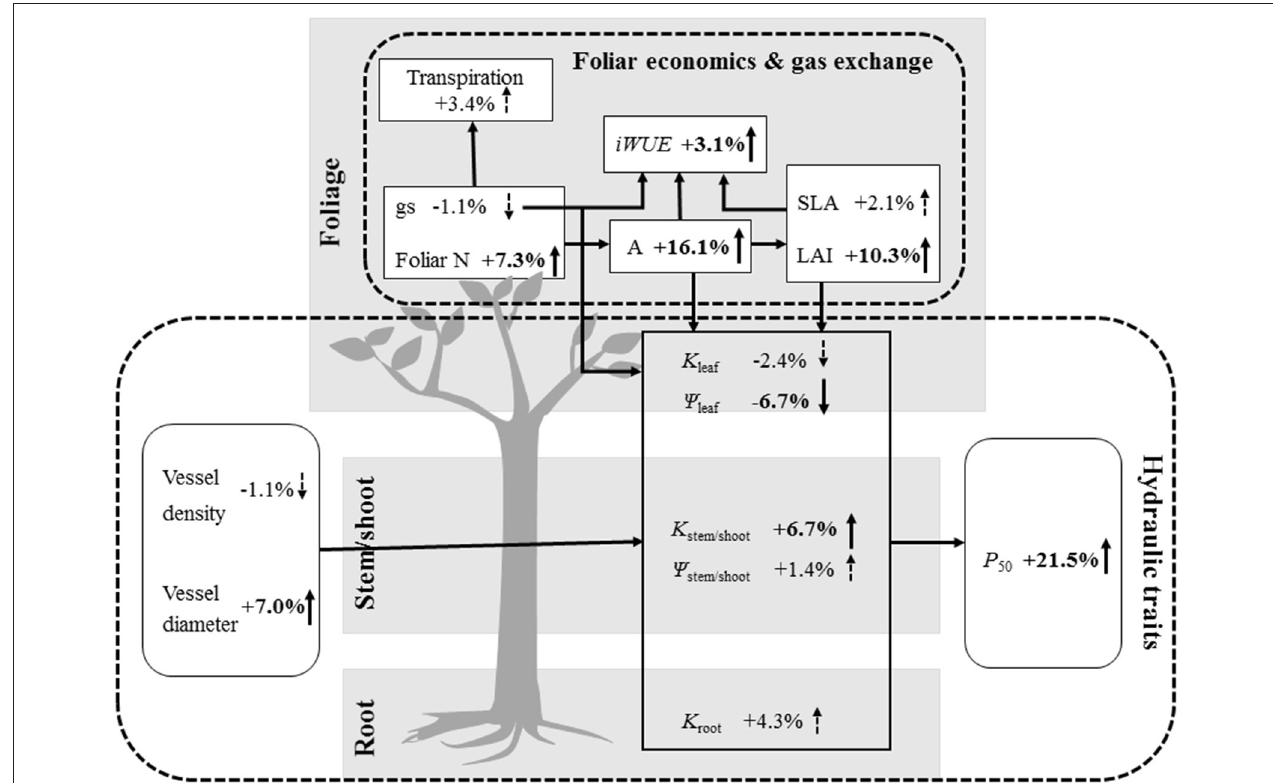
FIGURE 3 | Responses of leaf economics, gas exchange, and hydraulic traits to N addition. Transpiration, Transpiration rate; gs, stomatal conductance; foliar N, foliar N content; iWUE , intrinsic water-use efficiency; A, net photosynthetic rate; SLA, specific leaf area; LAI, leaf area index; Kleaf, Kstem/shoot and Kroot, hydraulic conductance of leaves, stems/shoots and roots; ψ leaf, leaf water potential; ψ stem/shoot, stem/shoot water potential; P 50 , water potential corresponding to 50% loss of hydraulic conductivity. The numbers and arrows represent increases or decreases under N addition, respectively, and significant changes are indicated with a solid line, while dashed lines represent results that were not